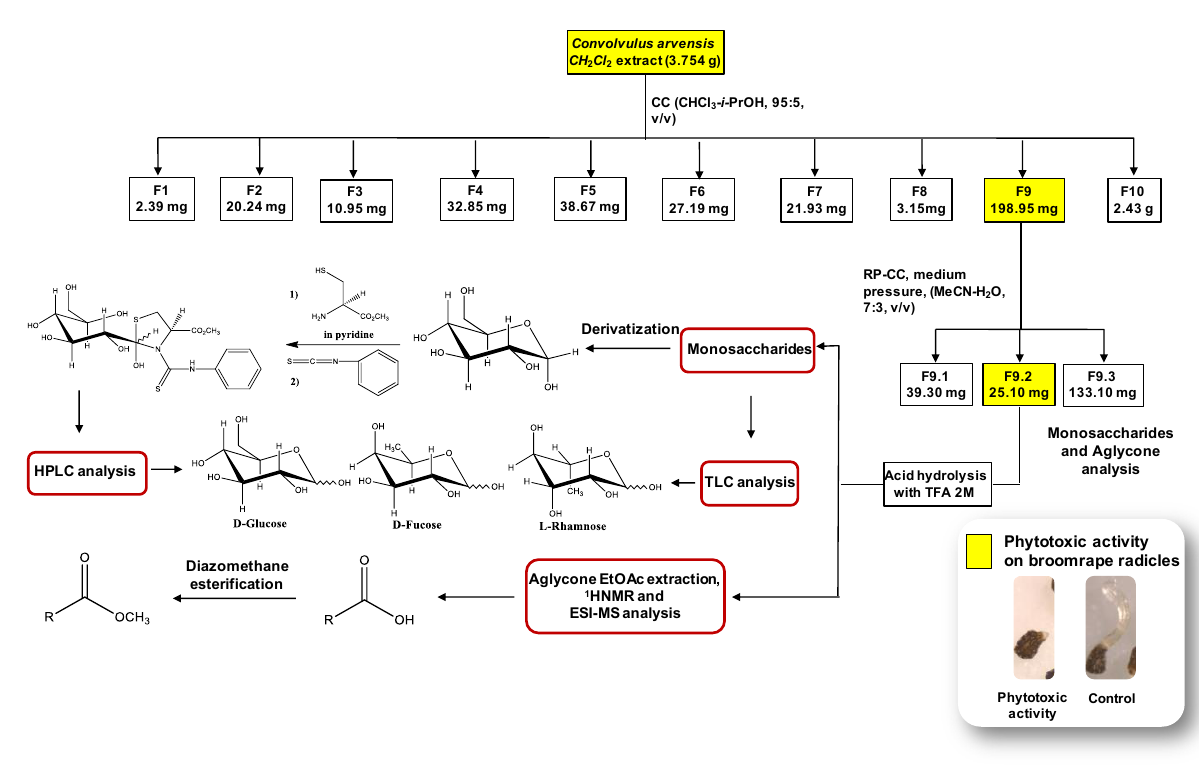
Figure 1. Diagram procedure of the activity-guided isolation and identification of arvensic acids as inhibitors of broomrape radicle growth.